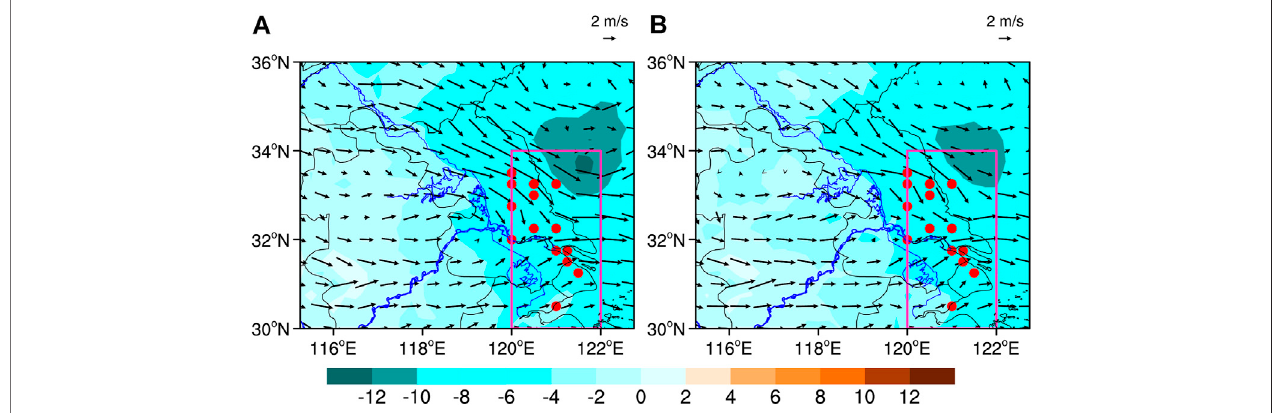
FIGURE6 | Composition differences ofsynoptic-scale circulations between the PWAFS forecasts and observations at WRWSoccurrence moments withdifferent leadtimes:1 – 3 h (A) and4 – 6 h (B) .Theshadingareasaregeopotentialheight( gpm )at700 hPa.Arrowsrepresenthorizontalwindat850 hPa( m/s ).Reddotsrepresent the CRA centers of WRWS over coastal areas of YHR (pink box).